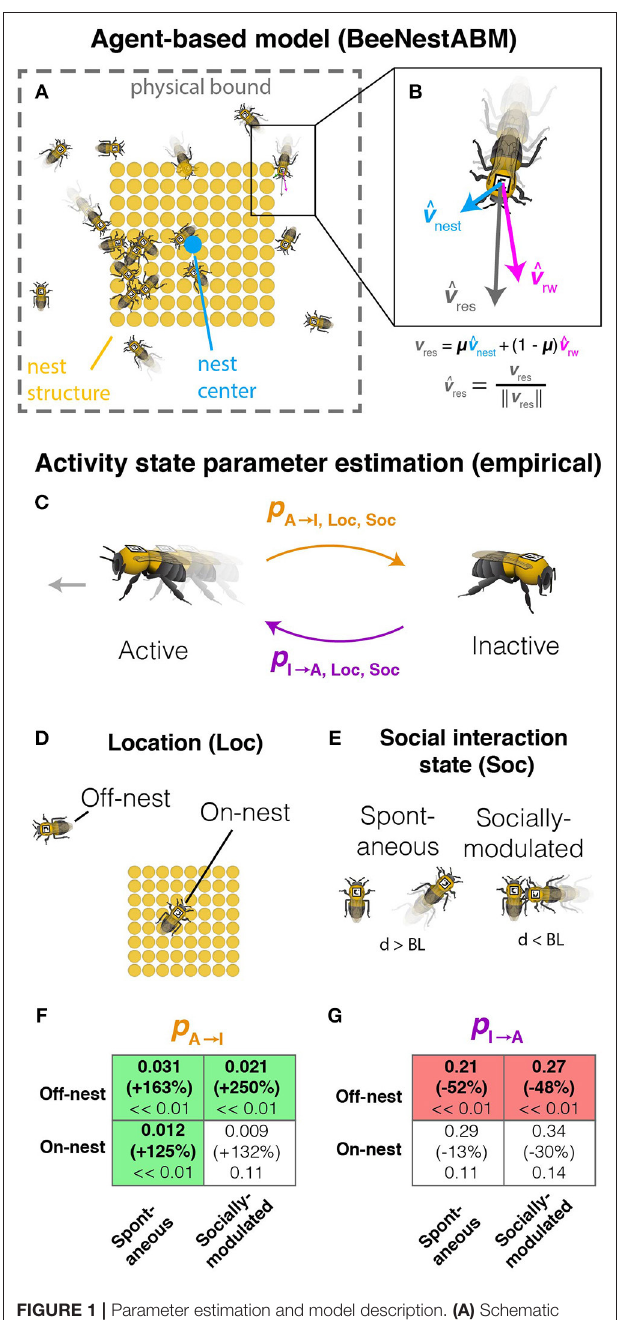
FIGURE 1 | Parameter estimation and model description. (A) Schematic diagram of model simulation, including individual workers, nest structure (filled tan circles), nest center (blue circle), and physical boundaries. (B) Model for simulated worker movement showing the random walk (v rw ), nest attraction (v nest ), and resultant (v res ) movement vectors. (C) Activity switching probabilities (active to inactive, p A → I , and inactive to active, p I → A ) are measured separately depending on whether bees are (D) located on or off the nest structure or (E) in physical contact with a nestmate. (F,G) Changes in probability of switching from active to inactive ( p A → I , F ) and switching from inactive to active state ( p I → A , G ) as a result of imidacloprid exposure. Probability changes are shown separately for combinations of location (Loc) and social interaction state (Soc). For each box, upper values show parameter (Continued)